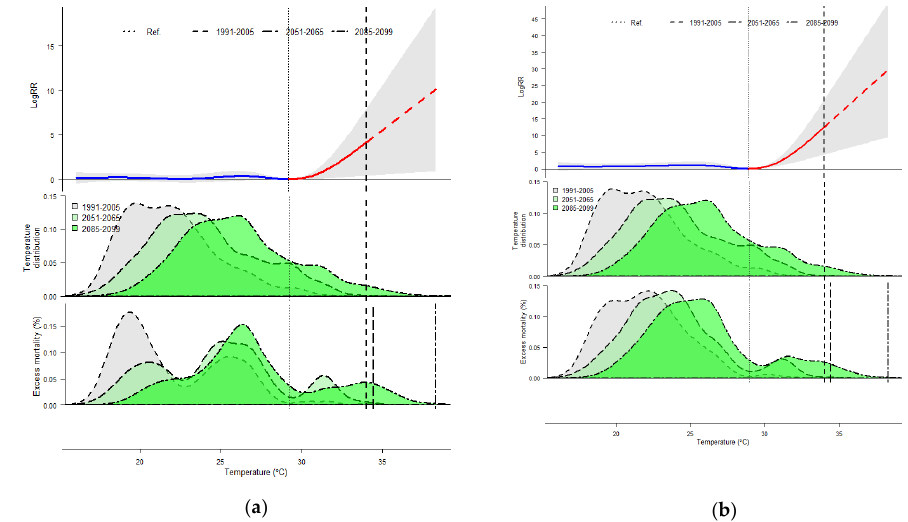
Figure 2. Temperature related mortality and excess mortality for the present and projected future periods in Lisbon metropolitan area (LMA) during the summer period for people aged <65 years ( a ) and 65+ years ( b ). Top panel: Exposure-response curve for temperature-mortality cumulative associations (logRR). The solid lines represent the logRR and the gray areas the 95% empirical confidence interval. The dotted vertical line corresponds to reference temperature (MMT) which divides the curve into cold and hot (blue and red lines, respectively). Middle panel: distribution of temperature values for the present period, 1991–2005 (grey area) and future periods, 2051–2065 (green area) and 2085–2099 (darker green area). Bottom panel: distribution of temperature-related excess mortality, expressed as the fraction of additional deaths (%) attributed to non-optimal temperature, compared with the reference temperature.